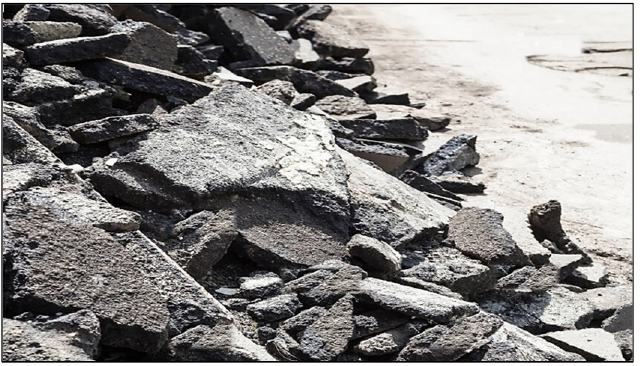
Figure 1. A stockpile of RAP.